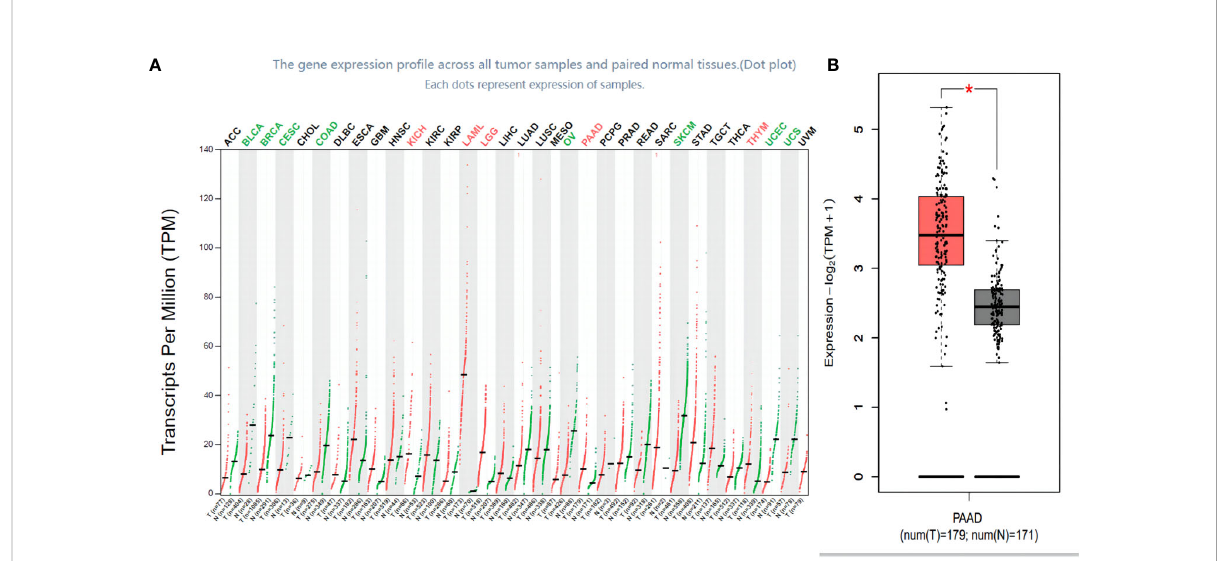
FIGURE 2 FOXN3 expression in carcinoma tissues. (A) FOXN3 expression in pan cancer in TCGA database. (B) FOXN3 expression in Pancreatic adenocarcinoma(PAAD) in TCGA database. *P <